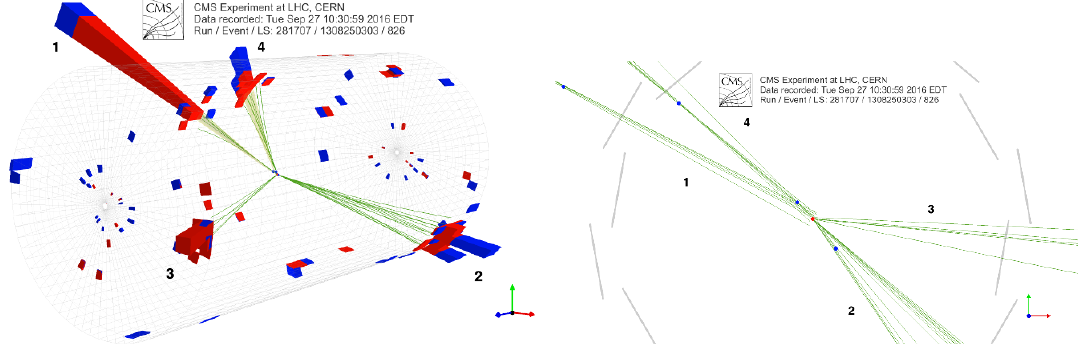
Figure 9 . Event display of an event passing both selection set 1 and selection set 5. The event contains four jets (jets 1 and 4 pass the emerging jet criteria), consistent with the decay of two massive mediator particles, each decaying to an SM quark and a dark QCD quark. In such a scenario, the dark mesons produced in the fragmentation of the dark quark would decay back to SM particles via the mediator, resulting in displaced vertices with decay distances on the mm scale. (Left) 3D display: the green lines represent reconstructed tracks, the red (blue) truncated pyramids represent energy in the ECAL (HCAL) detectors, respectively. (Right) Reconstructed tracks in (cid:26) { (cid:30) view. The (cid:12)lled blue circles represent reconstructed secondary vertices, while the (cid:12)lled red circle is the PV. The solid grey lines represent the innermost layer of the silicon pixel detector. No signi(cid:12)cant excess with respect to the SM prediction is observed. A 95% con(cid:12)dence level (CL) cross section upper bound is calculated following the modi(cid:12)ed frequentist CL s prescription [42{44], using an asymptotic approximation [45] for the pro(cid:12)le likelihood ratio based test statistic, where the systematic uncertainties are taken as nuisance parameters. The 95% CL limits on the signal cross section, expected, and observed exclusion contours on signal parameters are shown in (cid:12)gure 10 for m (cid:25) = 5 GeV. The dependence of the DK limit on m (cid:25) is weak for m (cid:25) between 1 and 10 GeV. Dark pion decay lengths between 5 DK DK